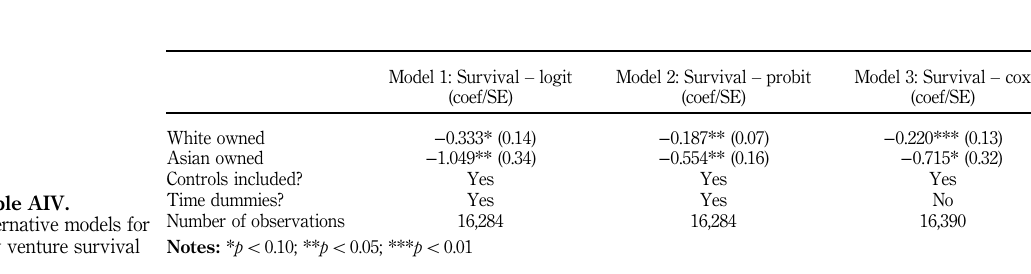
Table AIII. Assets and credit risk mediation pooled regressions